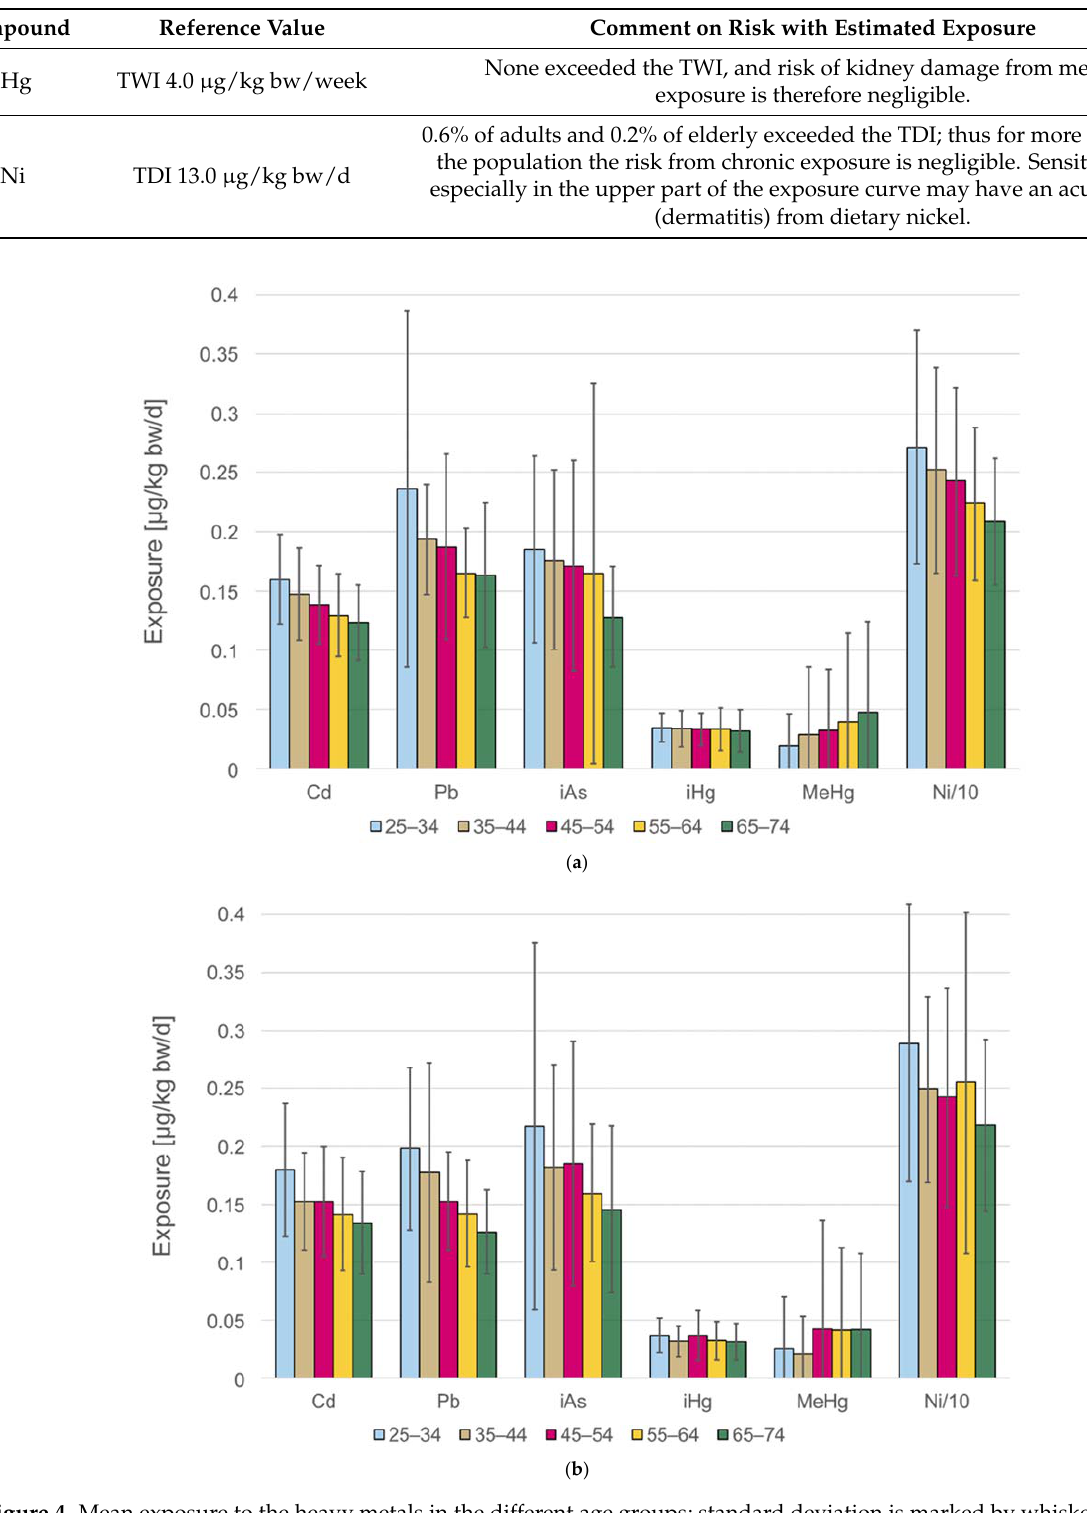
Figure 4. Mean exposure to the heavy metals in the different age groups; standard deviation is marked by whiskers. Nickel exposure is shown as 1/10 of the estimate for scale purposes. Note that the exposure assessment for Pb used different occurrence data for dairy between the two years, due to a decreasing concentration trend, and therefore comparison should be only made within a survey. ( a ) Exposure with FinDiet 2007 consumption data. ( b ) Exposure with FinDiet 2012 consumption